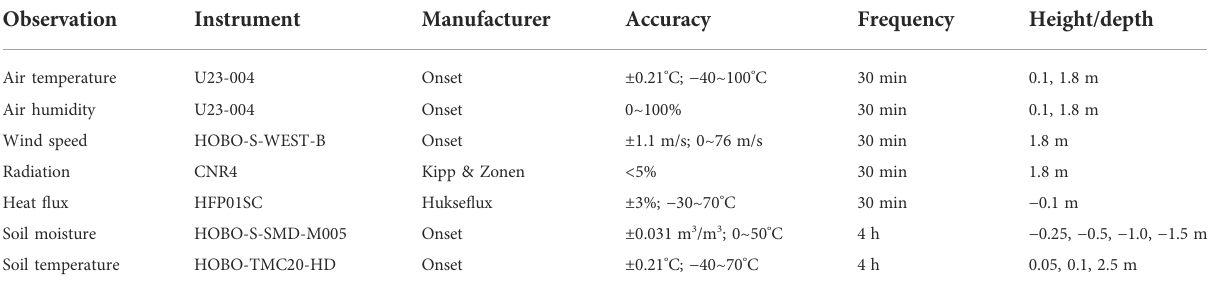
TABLE 1 Observation items and instruments of shadowy and sunny slopes monitoring